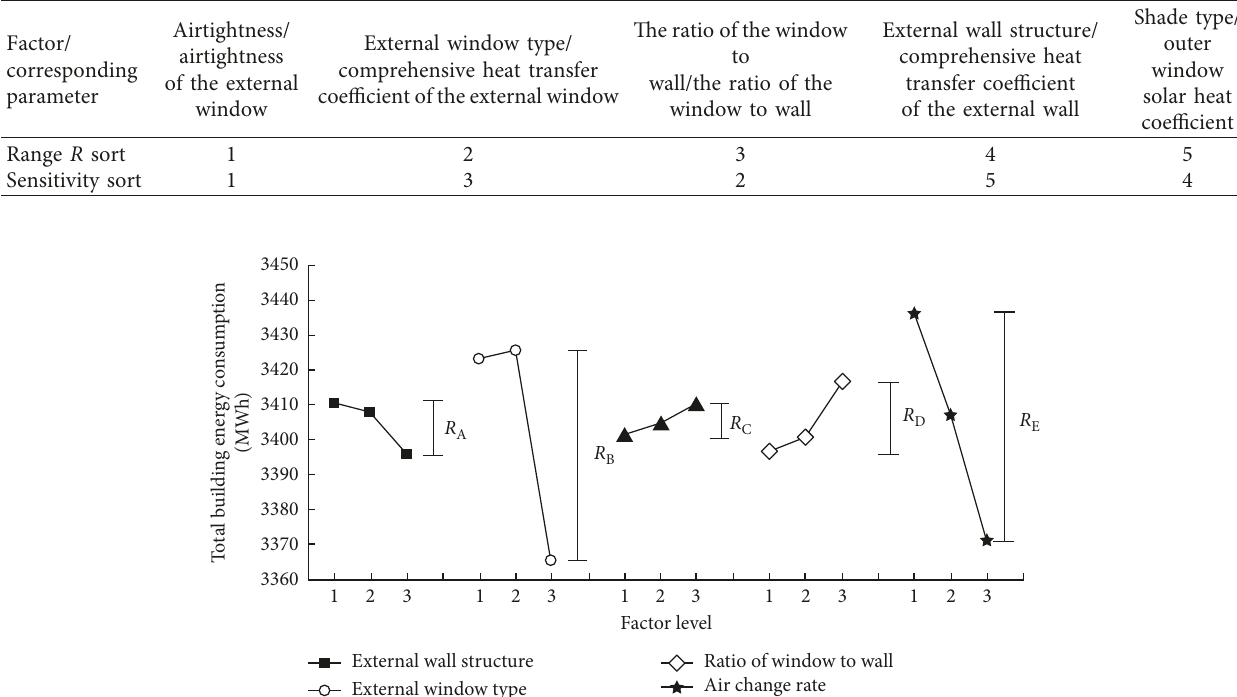
Table 9: Comparison between the factor range analysis and factor sensitivity analysis.